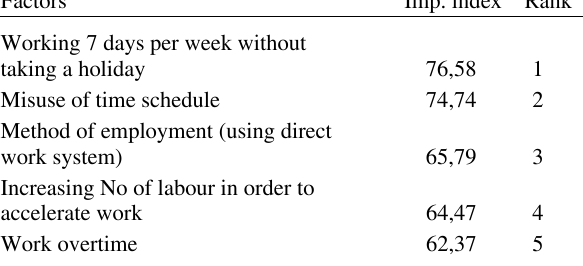
Table 4. Ranking factors in the time group Factors